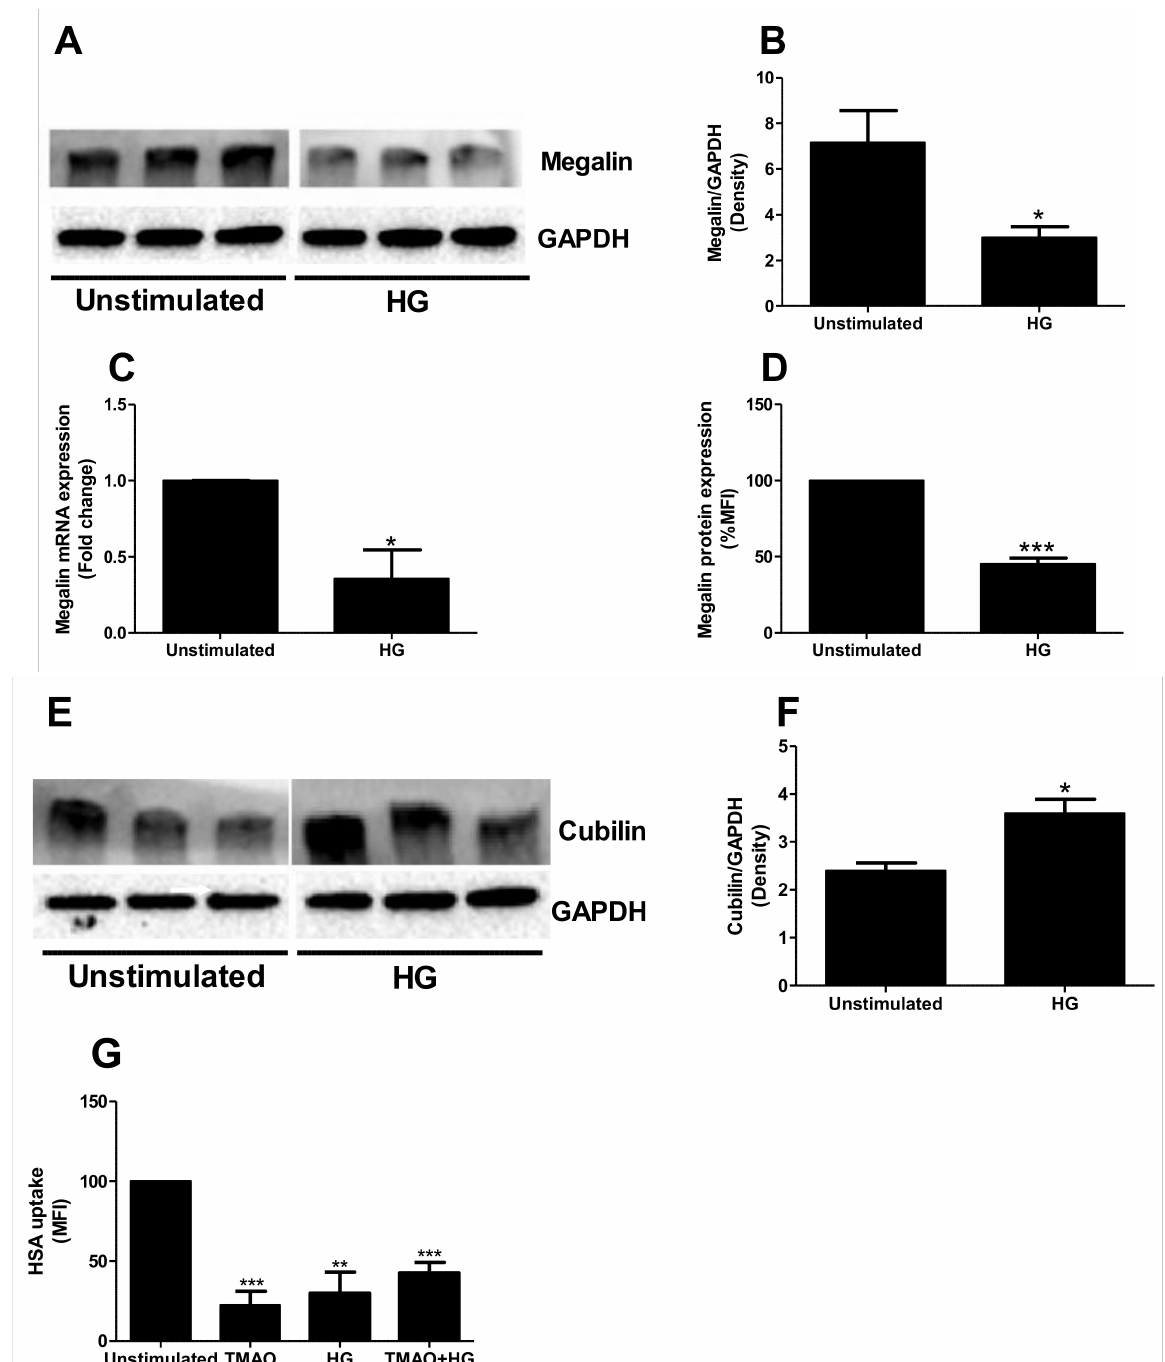
Figure 5. High glucose decreased megalin expression and albumin uptake in proximal tubular cells. HK-2 cells were stimulated with high glucose (30 mM) for 24 h ( A – F ) followed by Western blot analysis ( A , B , E , F ), flow cytometry analysis ( D ) and RT-PCR to evaluate megalin ( C ) and cubilin ( E , F ) expression. HSA uptake was also evaluated after 24 h of either high glucose (30 mM), TMAO (300 µ M) or in combination, stimulation ( G ). GAPDH was used as a loading control. Data are presented as mean ± SEM (n = 3 independent experiments). HG, high glucose. Unstimulated (low glucose, 5 mM). MFI, mean fluorescence intensity. HSA, human serum albumin. Asterisks denote statistical significance compared to unstimulated cells (* p < 0.05, ** p < 0.01, *** p <